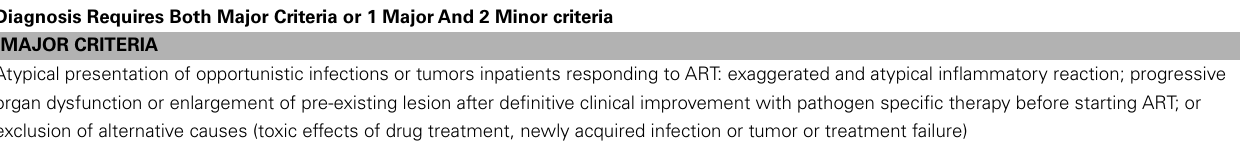
Table 2 | Criteria for IRIS (French et al.,